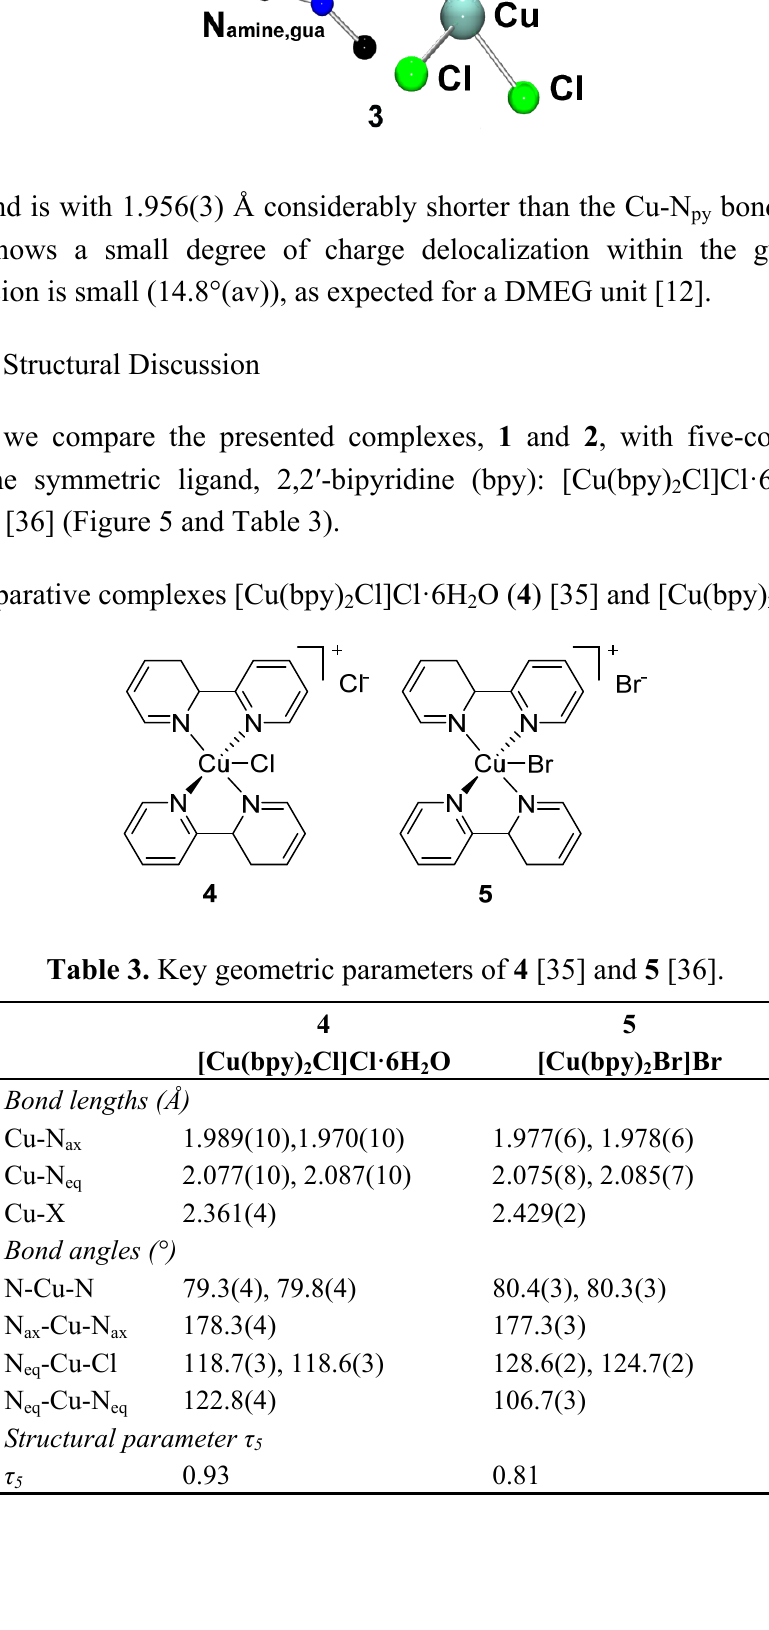
Figure 4. Molecular structure of [Cu(DMEGpy)Cl